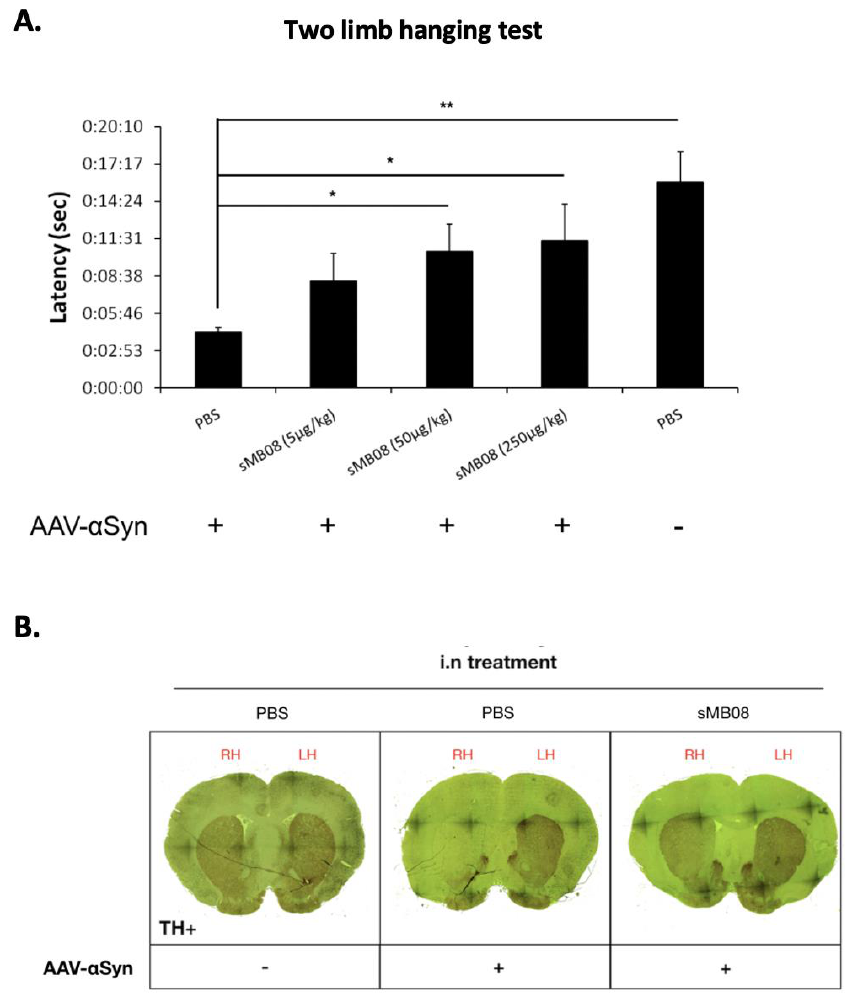
Figure 6. Treatment of sMB08 in the AAV- α Syn induced PD rat model. ( A ) Neuromuscular strength assessment using a two limb wire hang test. * p < 0.05, ** p < 0.01. Error bars represent standard error of the mean; ( B ) Brain sections of animals injected with AAV- α Syn that develop extensive and significantly greater loss of TH + and dopaminergic (DA) neurons and the effect of sMB08.